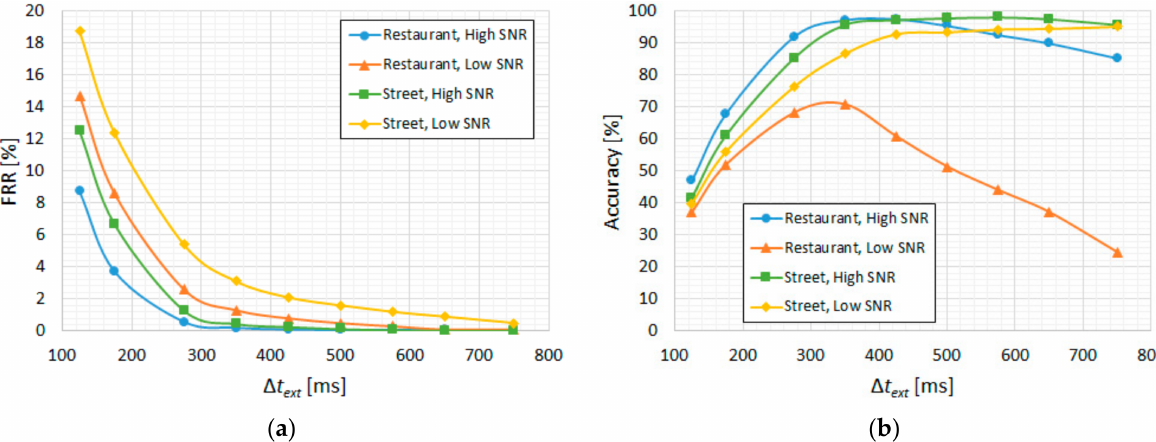
Figure 9. CENSREC-1-C subset B2; CNN-based VAD. “High SNR” groups the 10–20 dB levels and “Low SNR” groups the − 5–5 dB levels: ( a ) FRR vs. ∆ t ext ; ( b ) accuracy vs. ∆ t ext